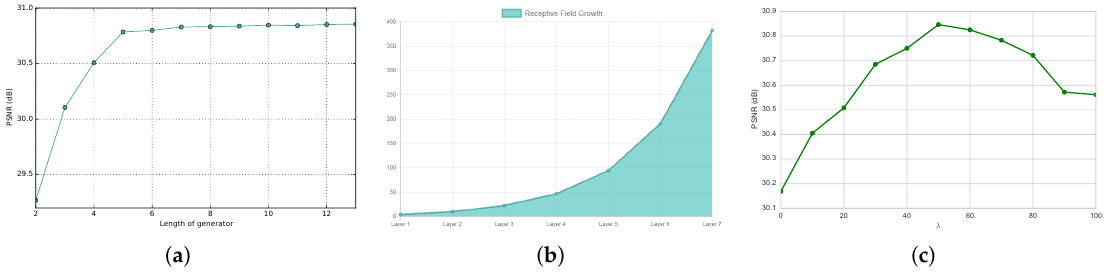
Figure 5. ( a ) Length of the generator vs. the PSNR of generated testing painting; ( b ) length of the discriminator vs. the size of the recptive field; ( c ) λ vs. the PSNR of the generated testing painting. Table 3. We evaluate the trade-off between performance and speed in networks with different depths. Length of